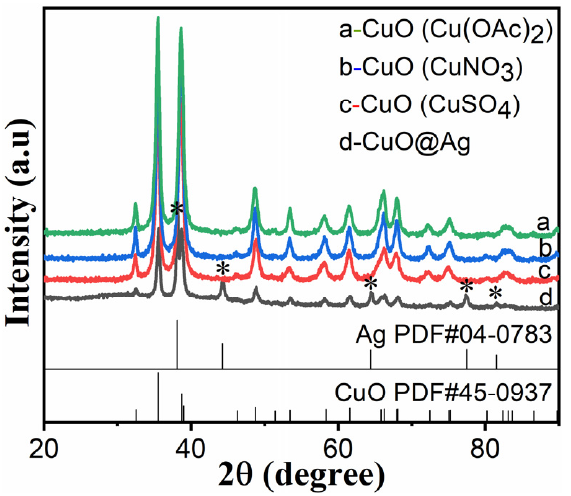
Figure 1. XRD patterns of CuO with different copper sources and CuO@Ag nanosheet composites: ( a ) Cu(CH 3 COO) 2 ·H 2 O, ( b ) CuNO 3 ·3H 2 O, ( c ) CuSO 4 ·5H 2 O, and ( d ) CuO@Ag.